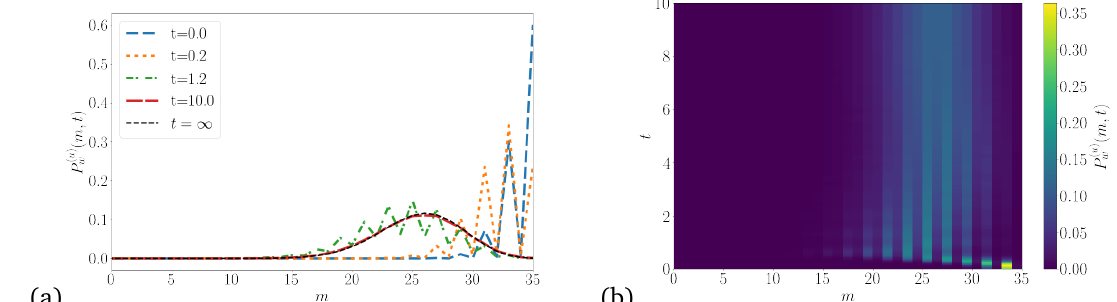
( m , t ) at times t = 0,0.2,1.2,10.0 after a w